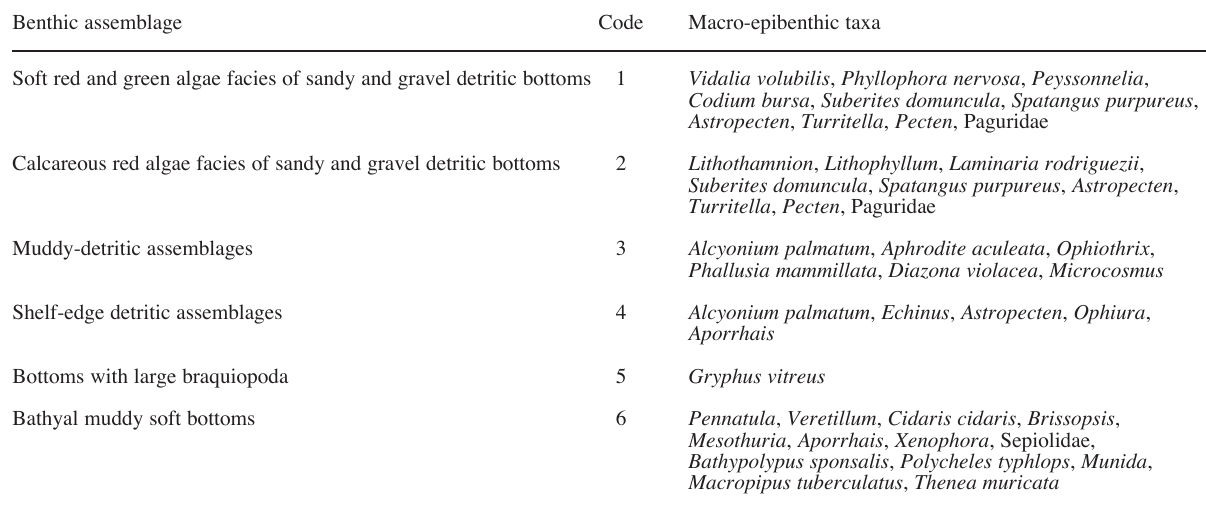
Table 1. – Major benthic communities identified during BALAR surveys according to Pérès (1985) and main macro-epibenthic species found. Benthic